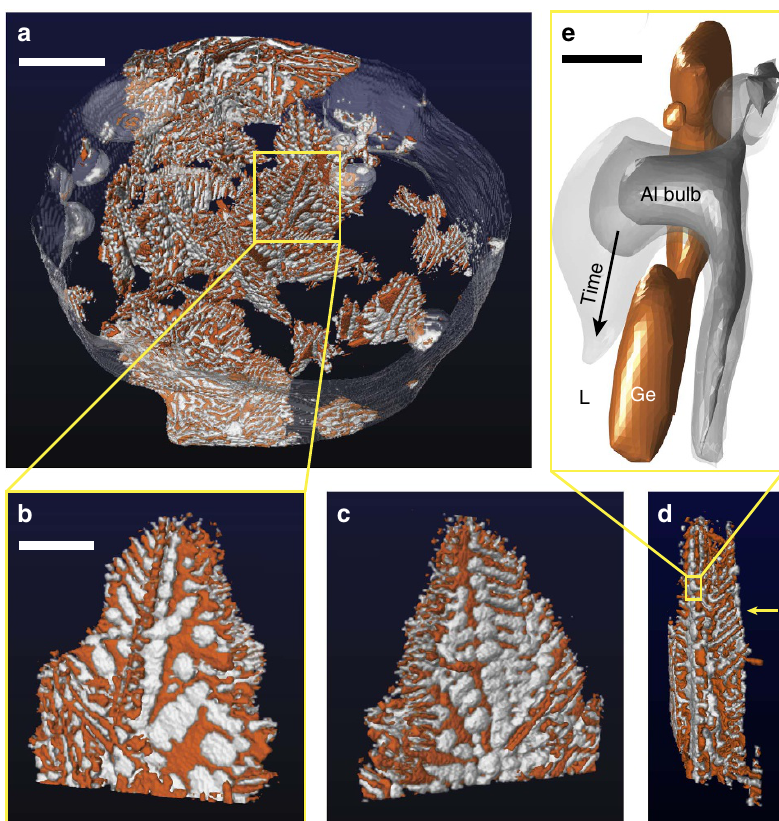
Figure 2 | Irregular eutectic microstructures across length scales. ( a ) Snapshot of the full tomographic region-of-interest during the growth process, where Ge is orange, Al is white and the melt is blue. One eutectic colony is boxed and isolated for subsequent 3D imaging. ( b – d ) The front (0 (cid:2) ), back (180 (cid:2) ), and side (90 (cid:2) ) views of this eutectic colony. The arrow in d points to a region of high structural regularity, wherein the Ge lamellae are nearly parallel. The front and back views ( b , c ) suggest that pockets of Al cover the exposed Ge surfaces. ( e ) In some cases, defects cause holes or gaps within the Ge plates; then, the Al bulbs can grow through these holes and spread across Ge {111}. Scale bar, 200 m m ( a ), 70 m m ( b ) and 10 m m ( e